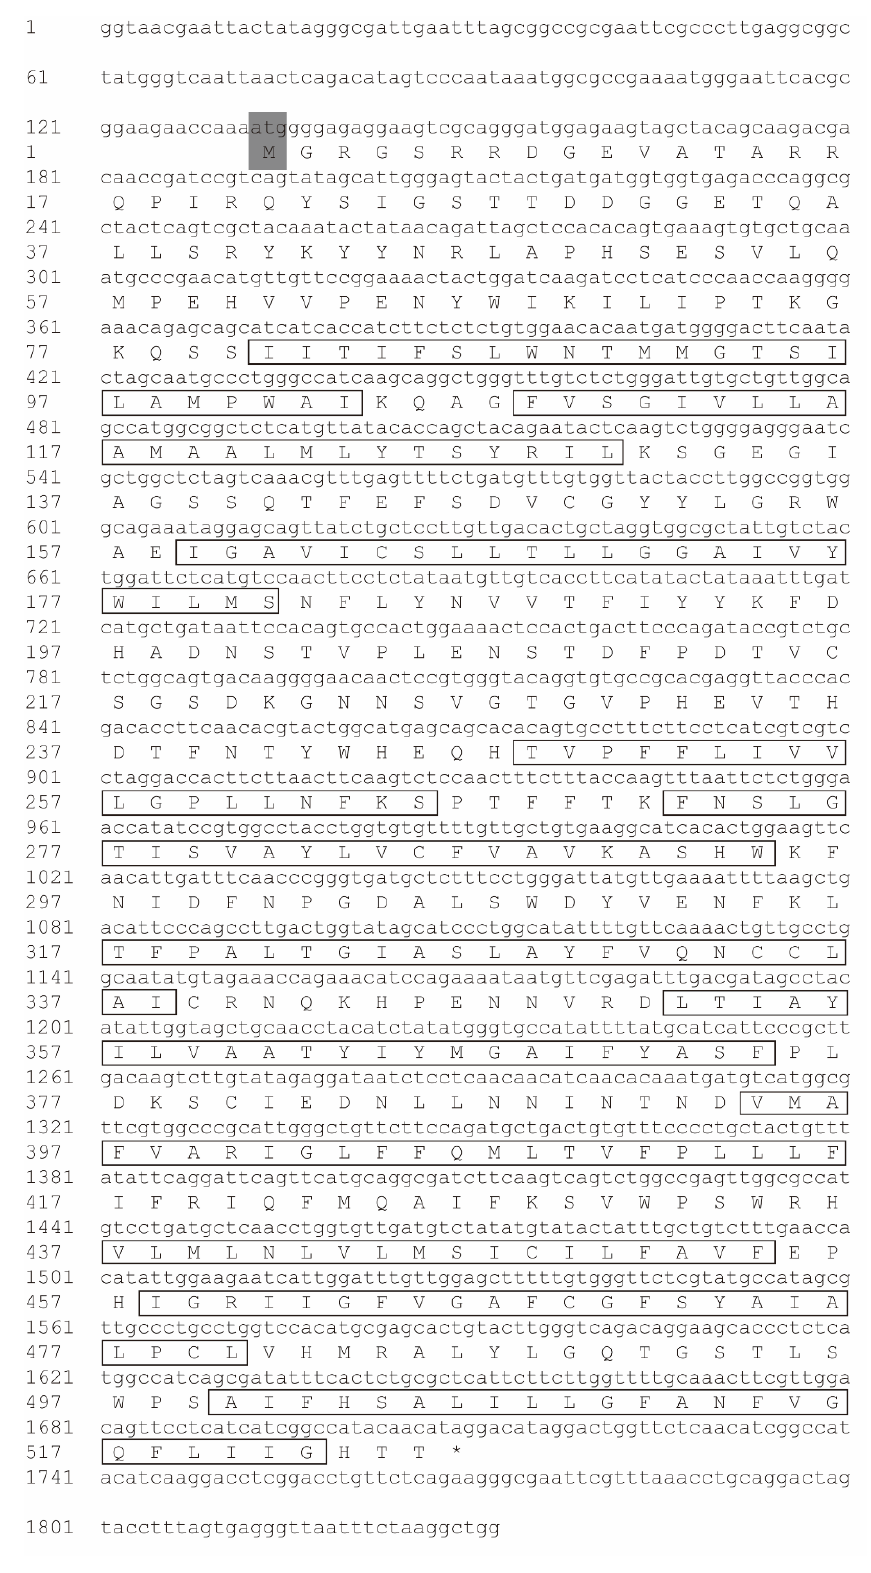
Figure 1. Nucleotide and deduced amino acid sequences of Solute Carrier Family 38 Member 9 ( slc38a9 ). The initiation codon (ATG) is shaded in grey and the asterisks (*) indicate the translation stop codon (TAG). The predicted transmembrane regions are indicated in rectangular boxes.